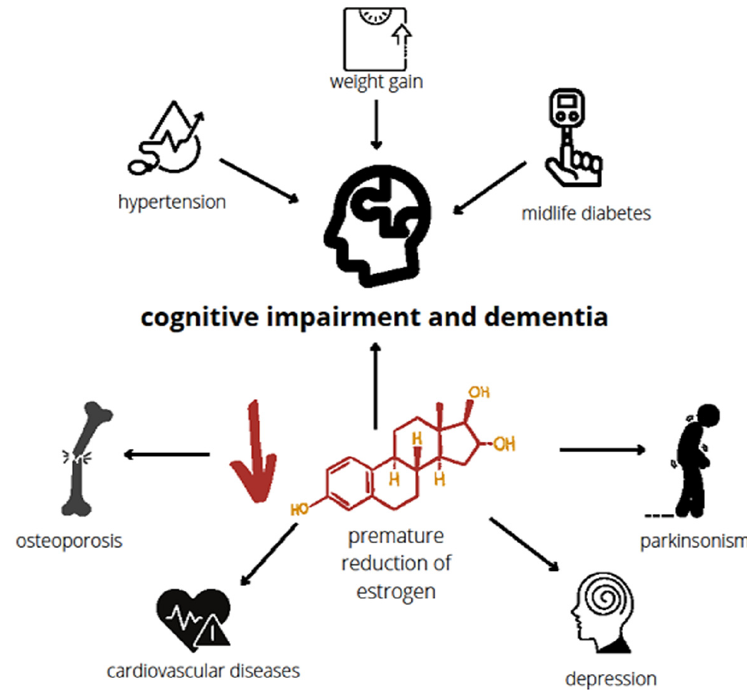
Figure 1. Risks following premature reduction in estrogen. The characteristic of premature and early menopause is a diminished level of estrogen that occurs before the physiological time of menopause. This reduction in estrogen increases the risk of dementia as well as cardiovascular disorders, osteoporosis, depression, and parkinsonism. Cognitive disorders and dementia could also be induced by hypertension, weight gain, and midlife diabetes which develop frequently in individuals with menopause [39–46].